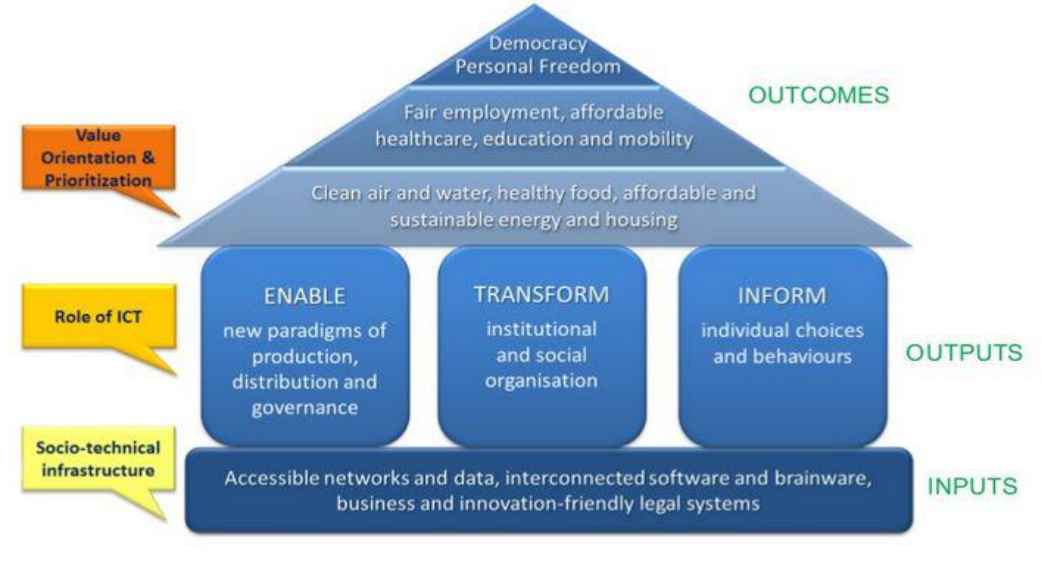
Figure 1 ICT in smart cities governance, Source: Ferro et al.